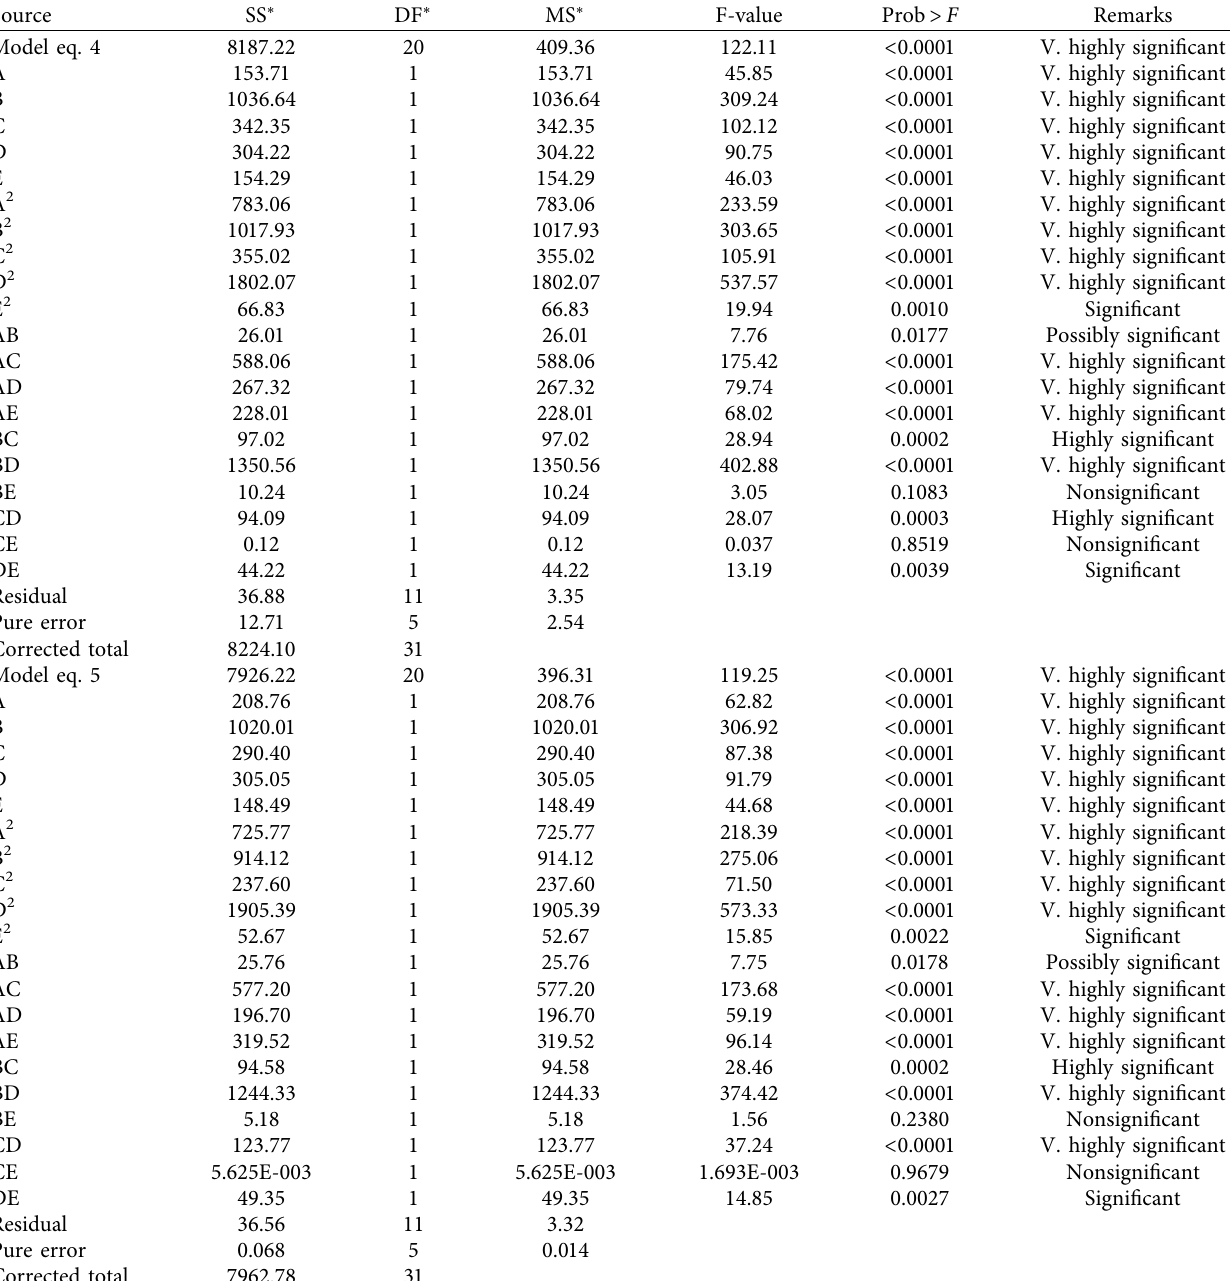
Table 2: Analysis of variance ANOVA for the predicted model